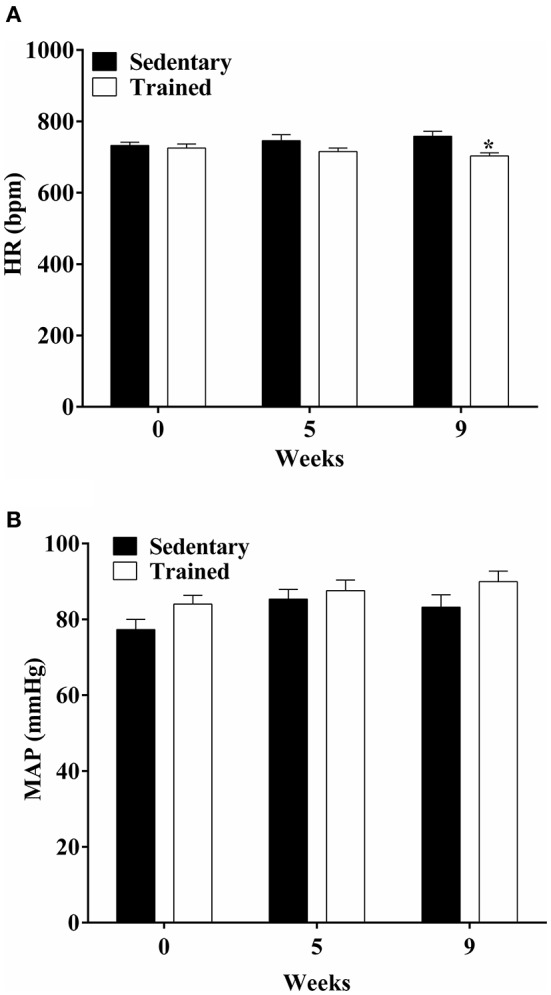
Exercise training induces decrease in heart rate (HR) in the trained group compared to their respective sedentary group. (A) HR, (B) mean arterial pressure (MAP) at 0, 5, and 9 weeks of treadmill exercise training. No changes were observed in MAP of the trained group when compared to the sedentary group. The experimental groups were composed of 27 trained mice and 14 sedentary mice. *P < 0.05 comparing trained with sedentary at week 9.